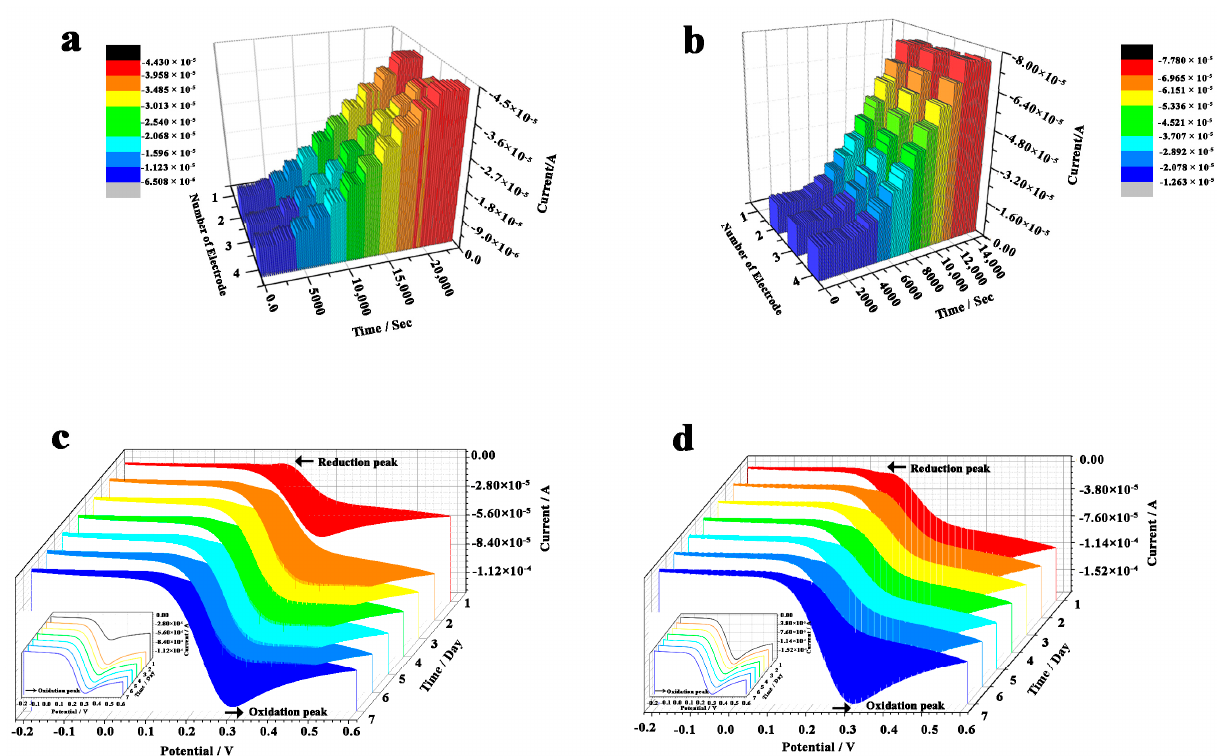
Figure 8. Analysis of the reproducibility and stability of the GA/CS/GDH/S-MWCN/GCE and GDH-NL-CBM2/NC/S- MWNT/GCE electrodes. ( a , b ) The reproducibility of three independent electrodes prepared with the GA/CS/GDH/S- MWCN/GCE and GDH-NL-CBM2/NC/S-MWNT/GCE, respectively, and the current changes with successive addition of different volumes of glucose (100 mM) at +0.3 V vs. Ag/AgCl were measured by the amperometric current–time curve method; ( c , d ) The corresponding stability of the GA/CS/GDH/S-MWCN/GCE and GDH-NL-CBM2/NC/S-MWNT/GCE electrodes evaluated by CV in 20 mM glucose in a week. The insert maps in c and d presented the oxidation reaction. The arrows in c and d indicated the scanning